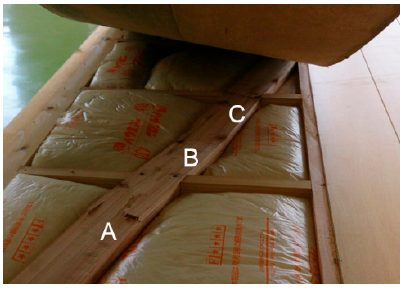
Figure 9. Photo of the deformed brace under the decorating wood board of specimen I.